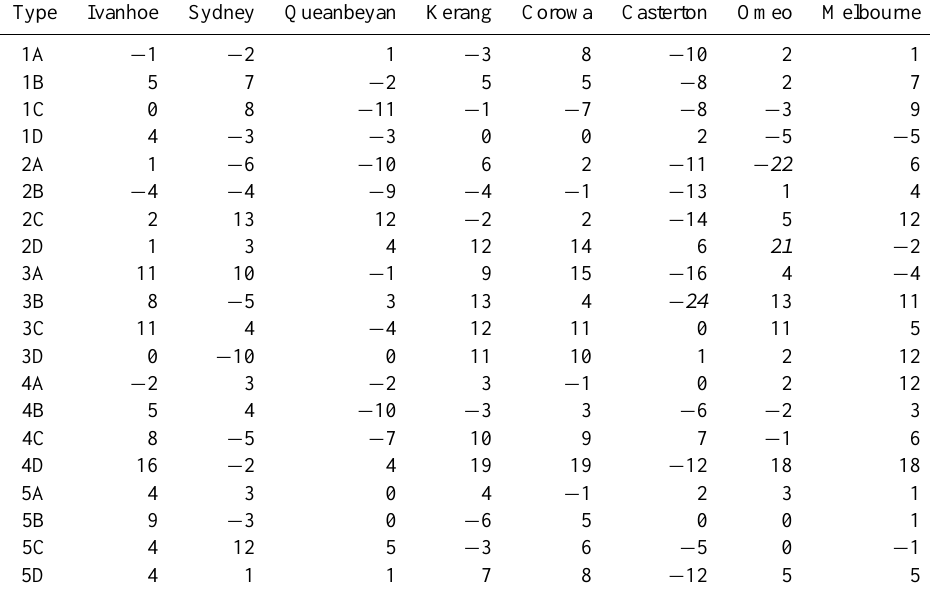
Table 2. Percentage change in the likelihood of a rain day (greater than 1mm) for a given synoptic type during winter 1984–1991